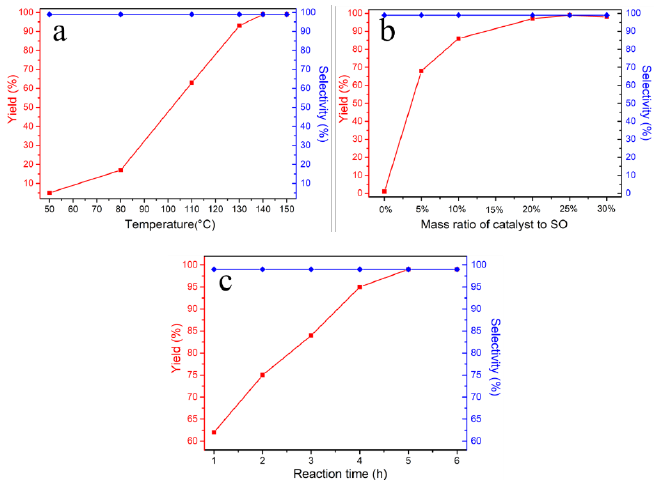
Figure 7. Effect of yield and selectivity as a function of ( a ) temperature, styrene oxide (5 mmol), 0.1 MPa CO 2 , 5 h, [HCP-CH 2 -Im][Cl]-1 (25 wt%); ( b ) mass ratio of catalyst to SO, styrene oxide (5 mmol), 0.1 MPa CO 2 , 140 °C, 5 h; ( c ) reaction time, styrene oxide (5 mmol), 0.1 MPa CO 2 , 140 °C, [HCP-CH 2 -Im][Cl]-1 (25 wt%).